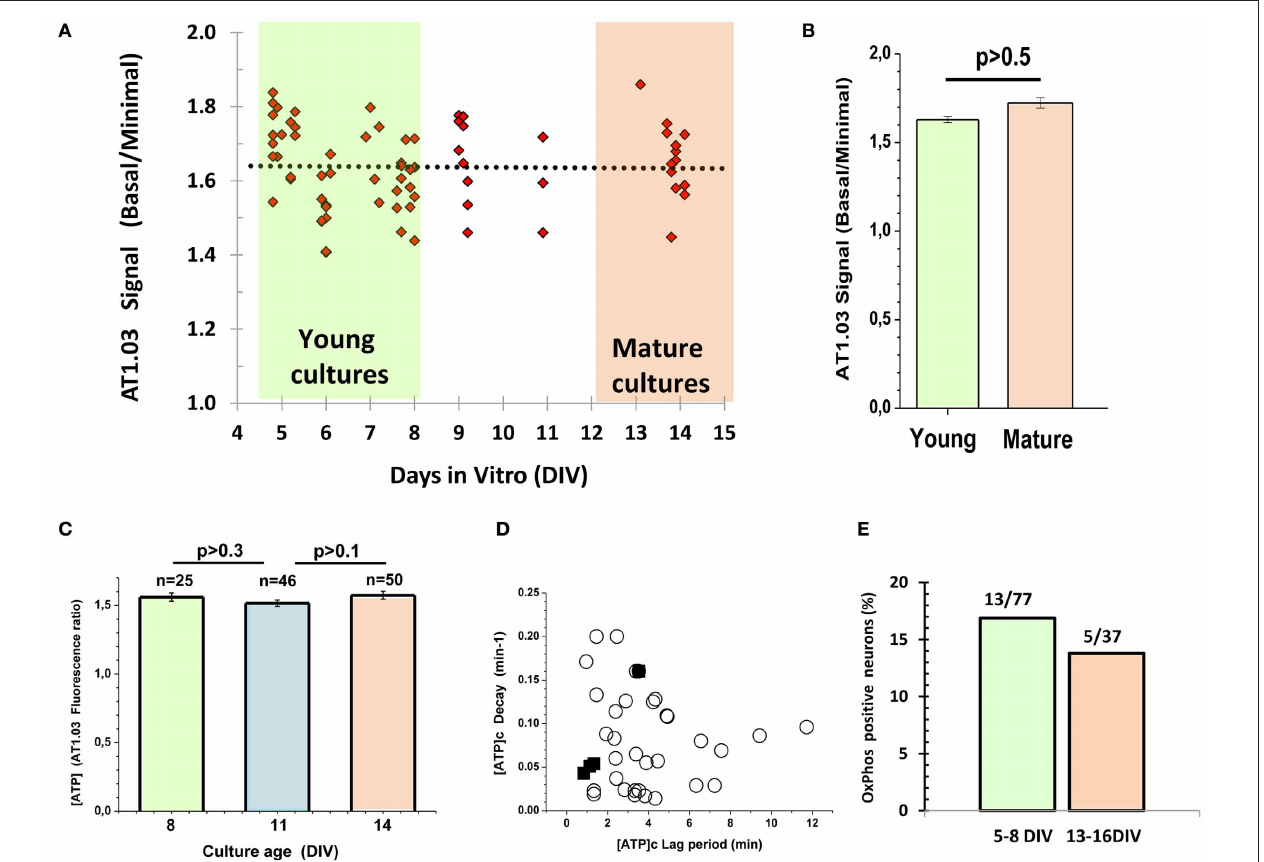
FIGURE 4 | Lack of correlation between neuronal metabolic parameters and maturity of embryonic cultured neurons. (A) Plot of time-dependence of the ratio between (1) the AT1.03 signal at the very beginning of the experiment and (2) the minimal signal observed upon suppression of both glycolytic and mitochondrial ATP synthesis. (B) The average values for young (5–8 DIV) and mature (13–14 DIV) cultures. (C) The averaged ratiometric signals of AT1.03 obtained at